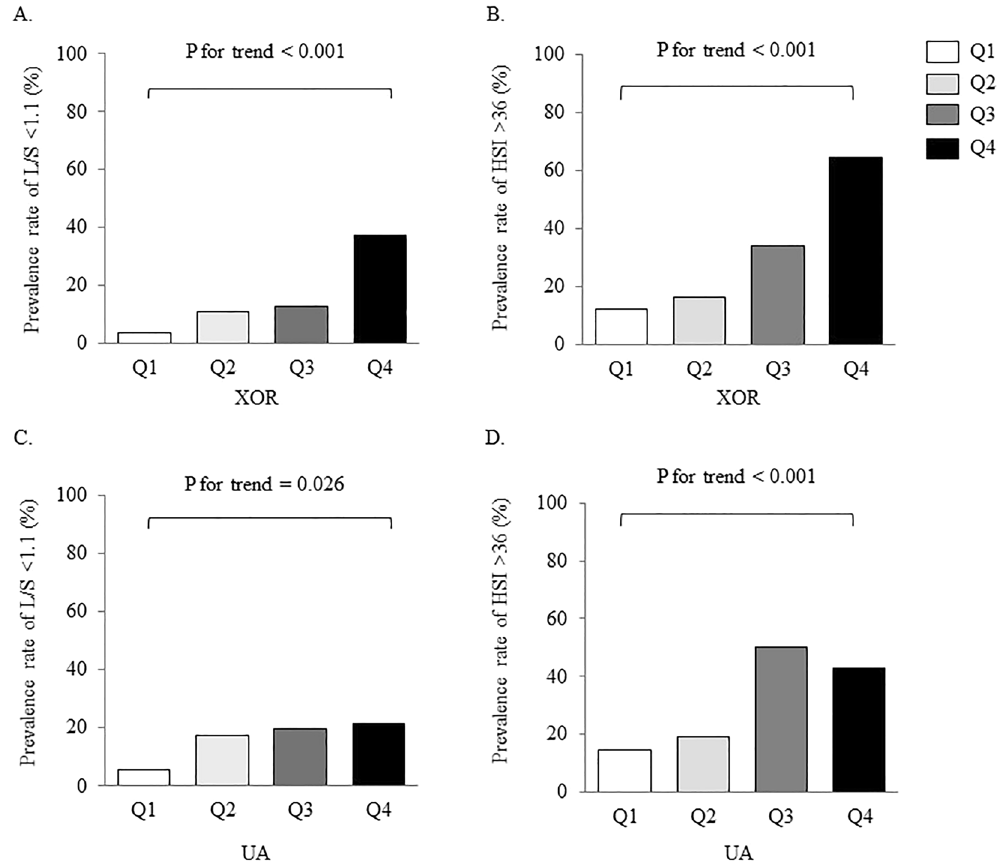
Figure 1. Comparisons of indices of hepatic steatosis among quadrants of xanthine oxidoreductase (XOR) activity or uric acid (UA) levels. ( A ) Plasma XOR activity and prevalence rate of liver-to-spleen (L/S) ratio < 1.1, ( B ) Serum UA levels and prevalence rate of L/S ratio < 1.1, ( C ) XOR and prevalence rate of hepatic steatosis index (HSI) > 36.0, ( D ) UA levels and prevalence rate of HSI > 36.0. The proportion of hepatic steatosis between quartiles was examined using the Cochran–Armitage test. Abbreviations: Q, quadrant.